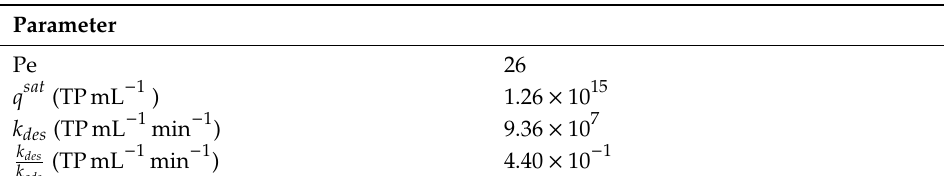
Table 1. Model parameters obtained from the fitting of frontal experiments. Column dimensions (L × d [cm]): 1 × 0.5; bed porosity ( ε ): 0.4; extra-column volume: 1.6 mL.